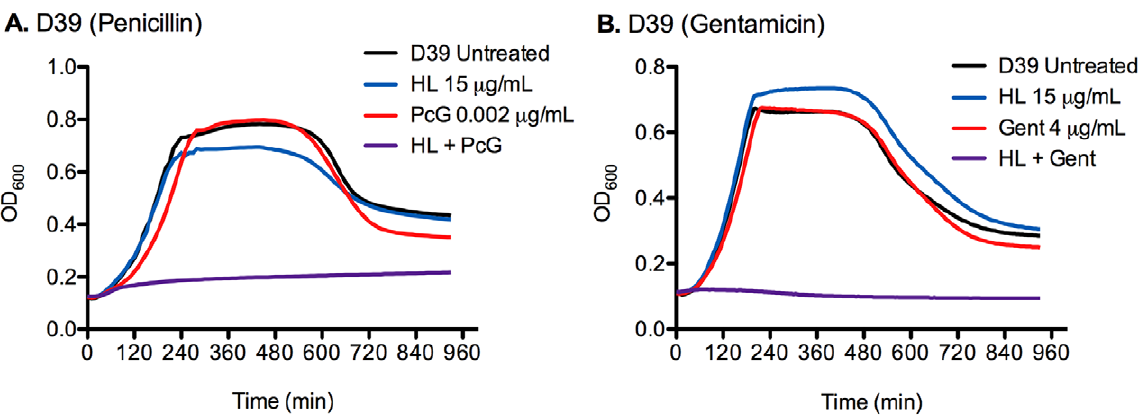
Figure 1. HAMLET lowers the MICs of gentamicin, erythromycin and penicillin. S. pneumoniae D39 were grown in broth for 16 hours in the presence of penicillin G (A) or gentamicin (B) with and without the addition of HAMLET. The figure shows representative growth curves for the lowest concentration of antibiotic and HAMLET that inhibited bacterial growth by combination treatment without either agent alone affecting growth.